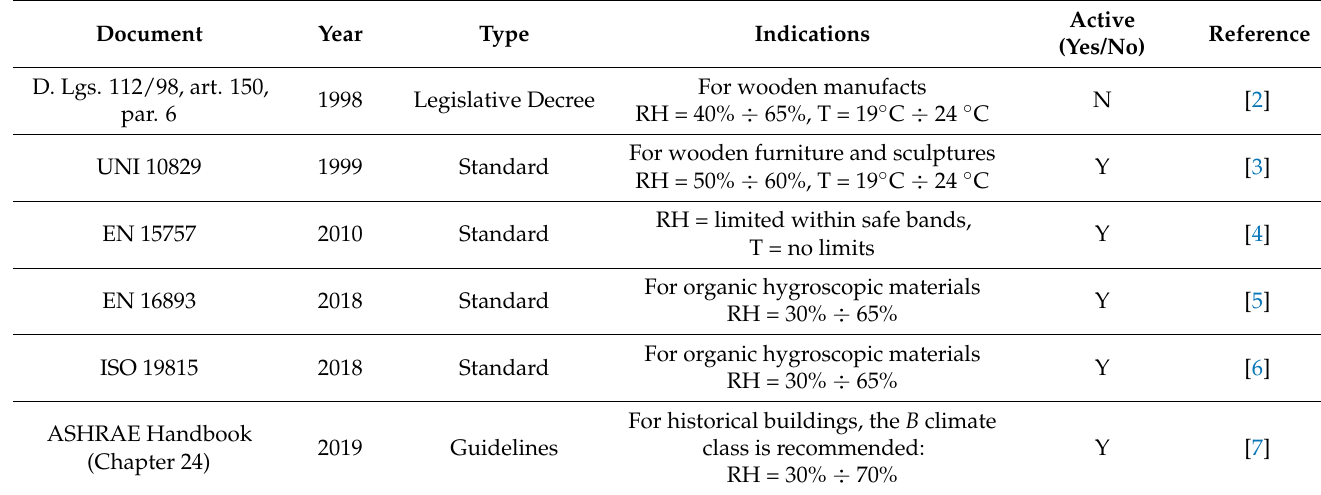
Table 1. International guidelines on the preservation of wooden cultural